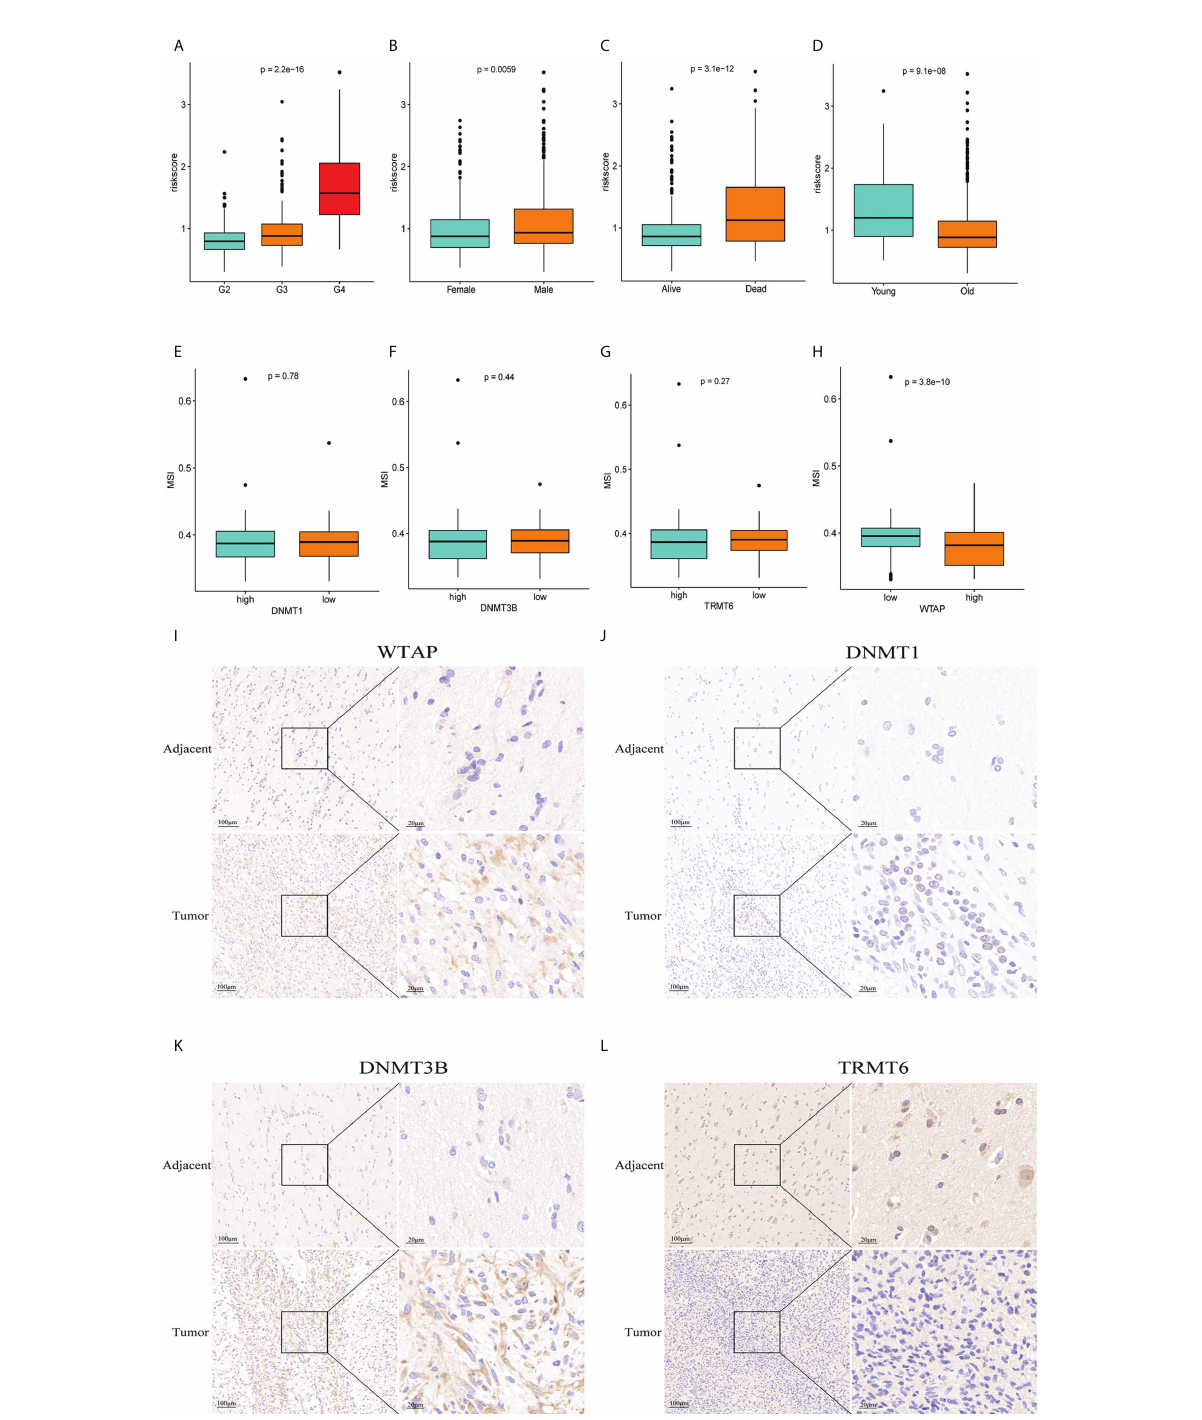
FIGURE 9 Clinical correlation analysis and immunohistochemistry. (A – D) There was a signi fi cant correlation between tumor grade, sex, survival status, age and risk score of patients with glioma. (E – H) Correlation between genes WTA P, TRMT6 , DNMT1 , DNMT3B and MSI (P = 0.78, P = 0.44, P = 0.27, P = 3.8e-10). Immunohistochemistry showed that the expression of WTAP (I) , DNMT1 (J) , and DNMT3B (K) in tumor tissue was signi fi cantly higher than that in adjacent tissue, whereas the expression of TRMT6 (L) was low in glioma tissue, which was consistent with the data analysis